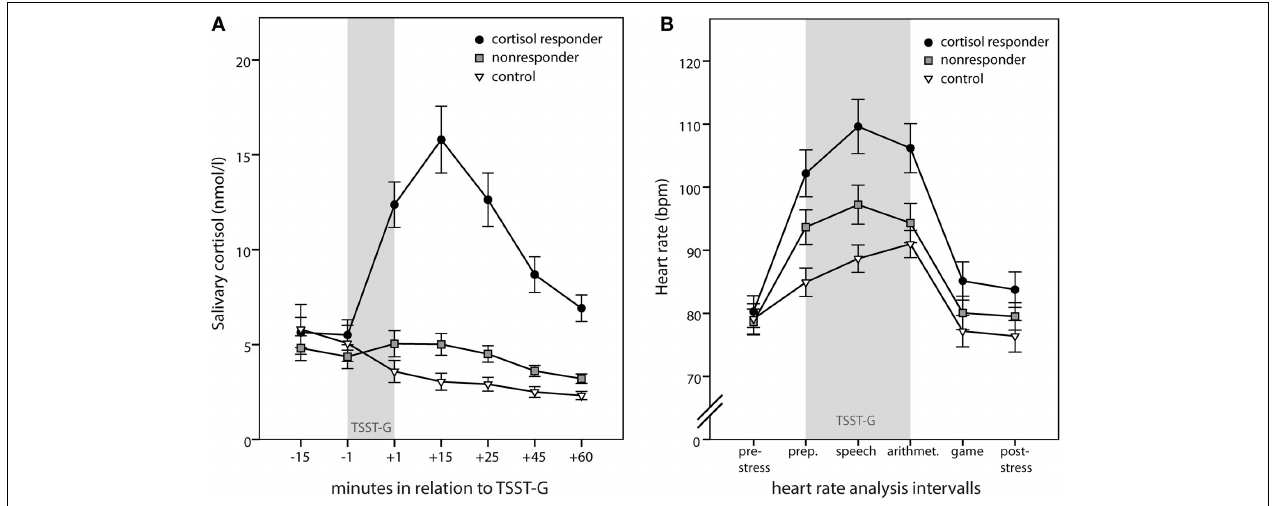
FIGURE 2 | Physiologic stress markers. Time course of salivary cortisol (A) and heart rate (B) . Gray bars indicate the timing of the Trier Social Stress Test for Groups (TSST-G). Depicted are means ± standard errors of the mean (s.e.m.).